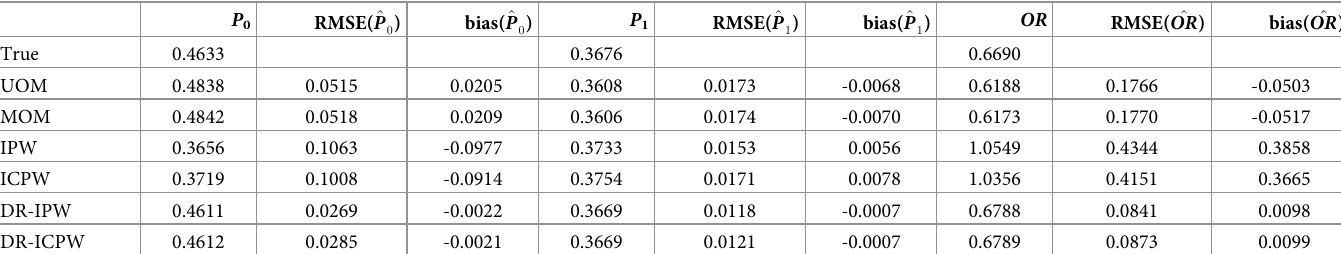
Table 12. Result of the doubly robust sensitivity analysis under exposure model